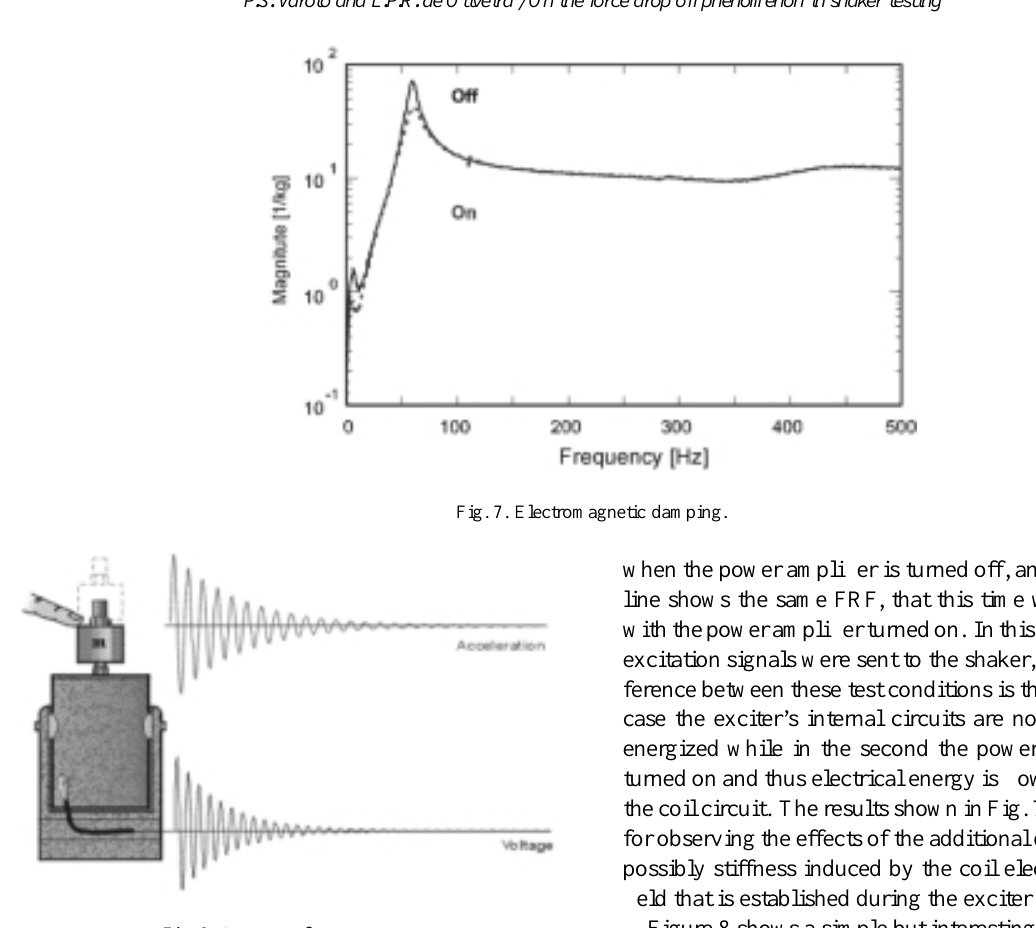
Fig. 8. Armature free